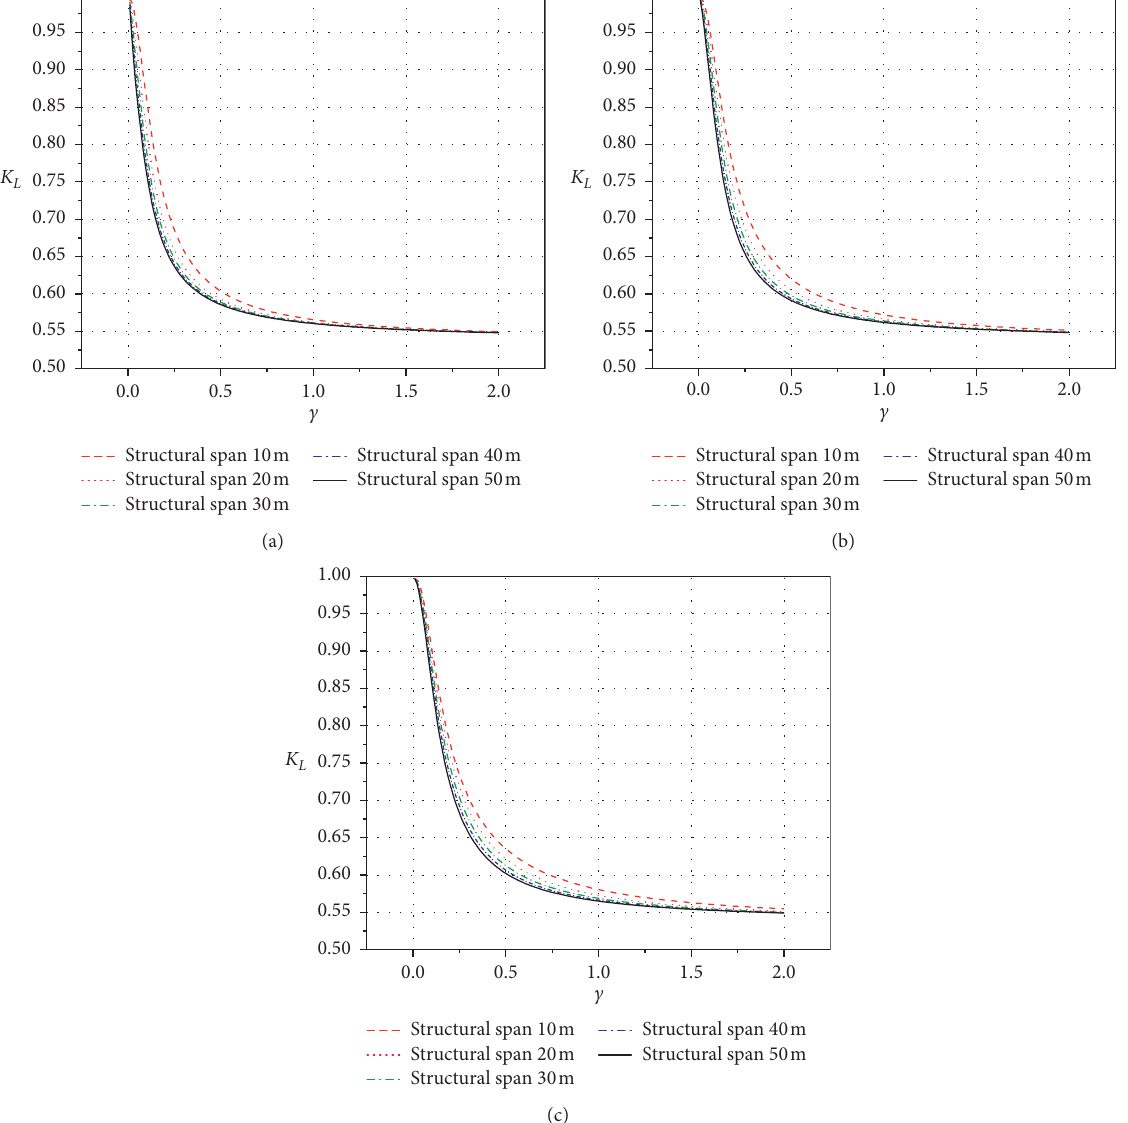
Figure 5: Equivalent load transformation factors of fixed end one-way members using Mills’ formula parameters: (a) W � 1kg. (b) W � 10kg. (c) W �